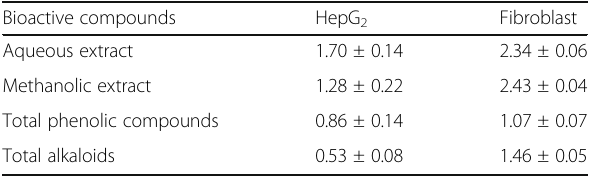
Table 1 IC 50 values (mg/ml) obtained for the phenolic compounds, alkaloids, aqueous, and methanolic extracts of